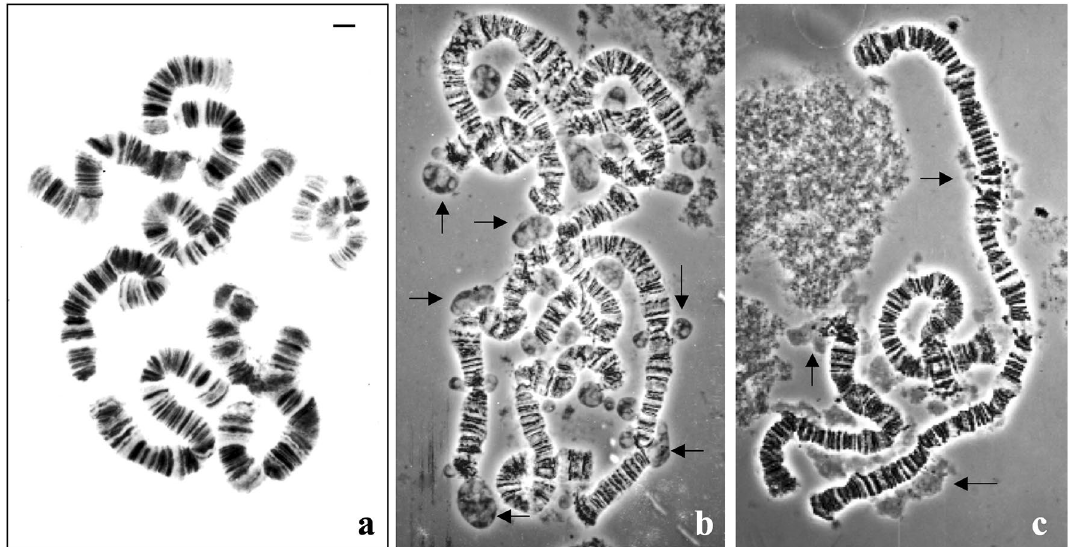
Figure 1. ( a–c ) Polytene chromosomes of Schwenkfeldina sp. ( a ) Orcein staining photographed under bright field allows chromosome visualisation but not extrachromosomal structures of interest to this work. ( b , c ) Phase contrast images showing two morphological aspects often observed in the nuclear entities of this species. The arrows point to some examples of structures, either disconnected or attached to the chromosomes, that were eventually identified as micronucleoli on the basis of in situ hybridisation results. ( b ) Nucleolar bodies displaying sharp edges and exhibiting some internal structure and ( c ) micronucleoli with less sharp edges and apparently devoid of internal structure. Bar = 15